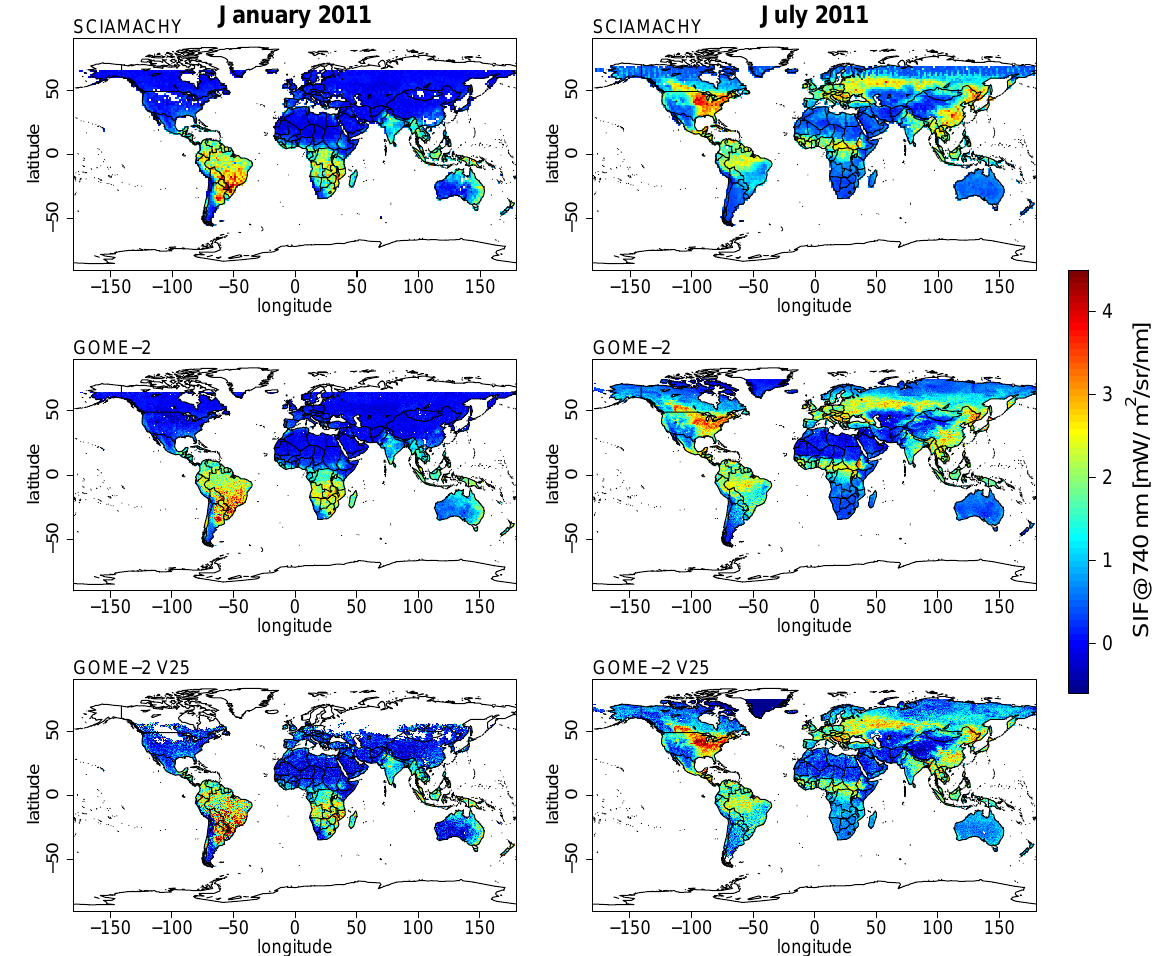
Figure 10. Monthly composites of SIF at 740nm for January (left column) and July (right column) 2011. The upper row depicts SIF results using SCIAMACHY data and the rows below show SIF composites derived from GOME-2 data using our algorithm (middle row) and SIF results provided by Joiner et al. (2014) (bottom row). The SCIAMACHY composites and results from Joiner et al. (2014) are scaled by the relationships in Table 2 to ensure a good visual